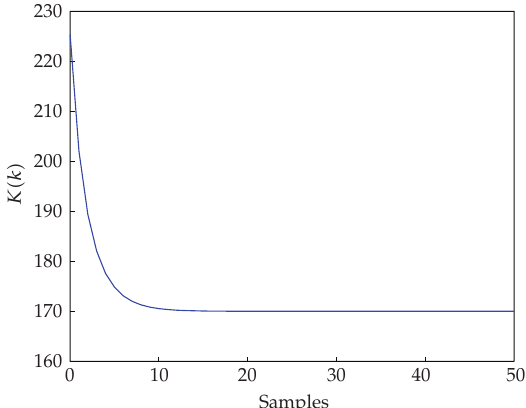
Figure 2: Evolution of the control sequence for the solution of Figure